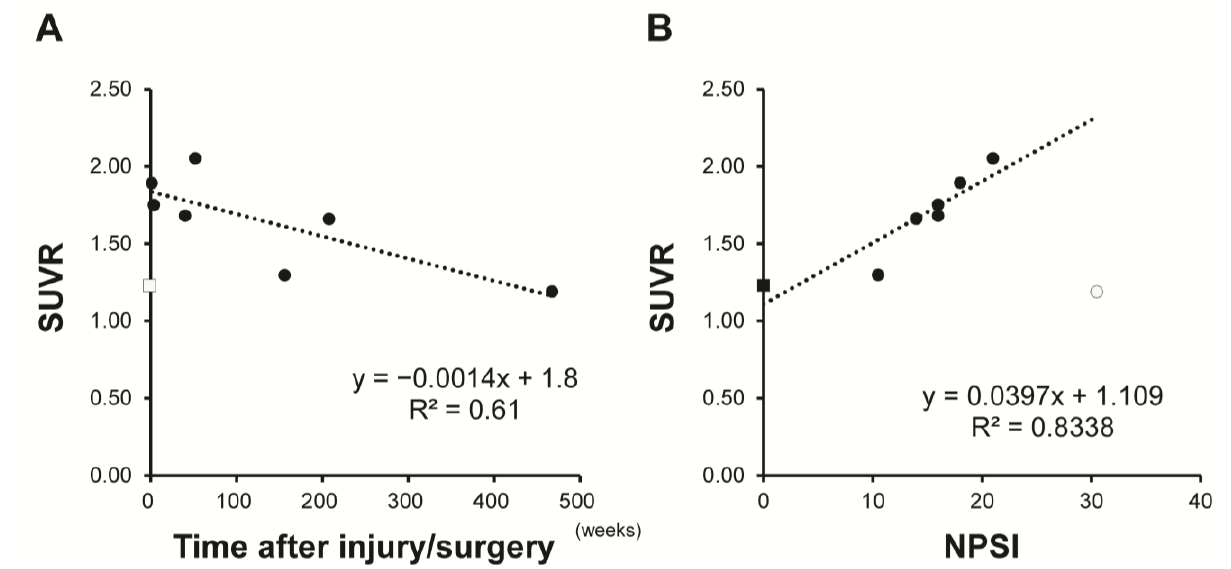
Figure 6. Relationship between standardized uptake value ratio (SUVR) and time after injury/surgery ( A ) and Neuropathic Pain System Inventory (NPSI) ( B ). SUVR was negatively correlated with time after injury/surgery and positively correlated with NPSI total score. Square markers: patients; Round marker: healthy subject; Outlined marker: excluded data for Pearson correlation analysis.